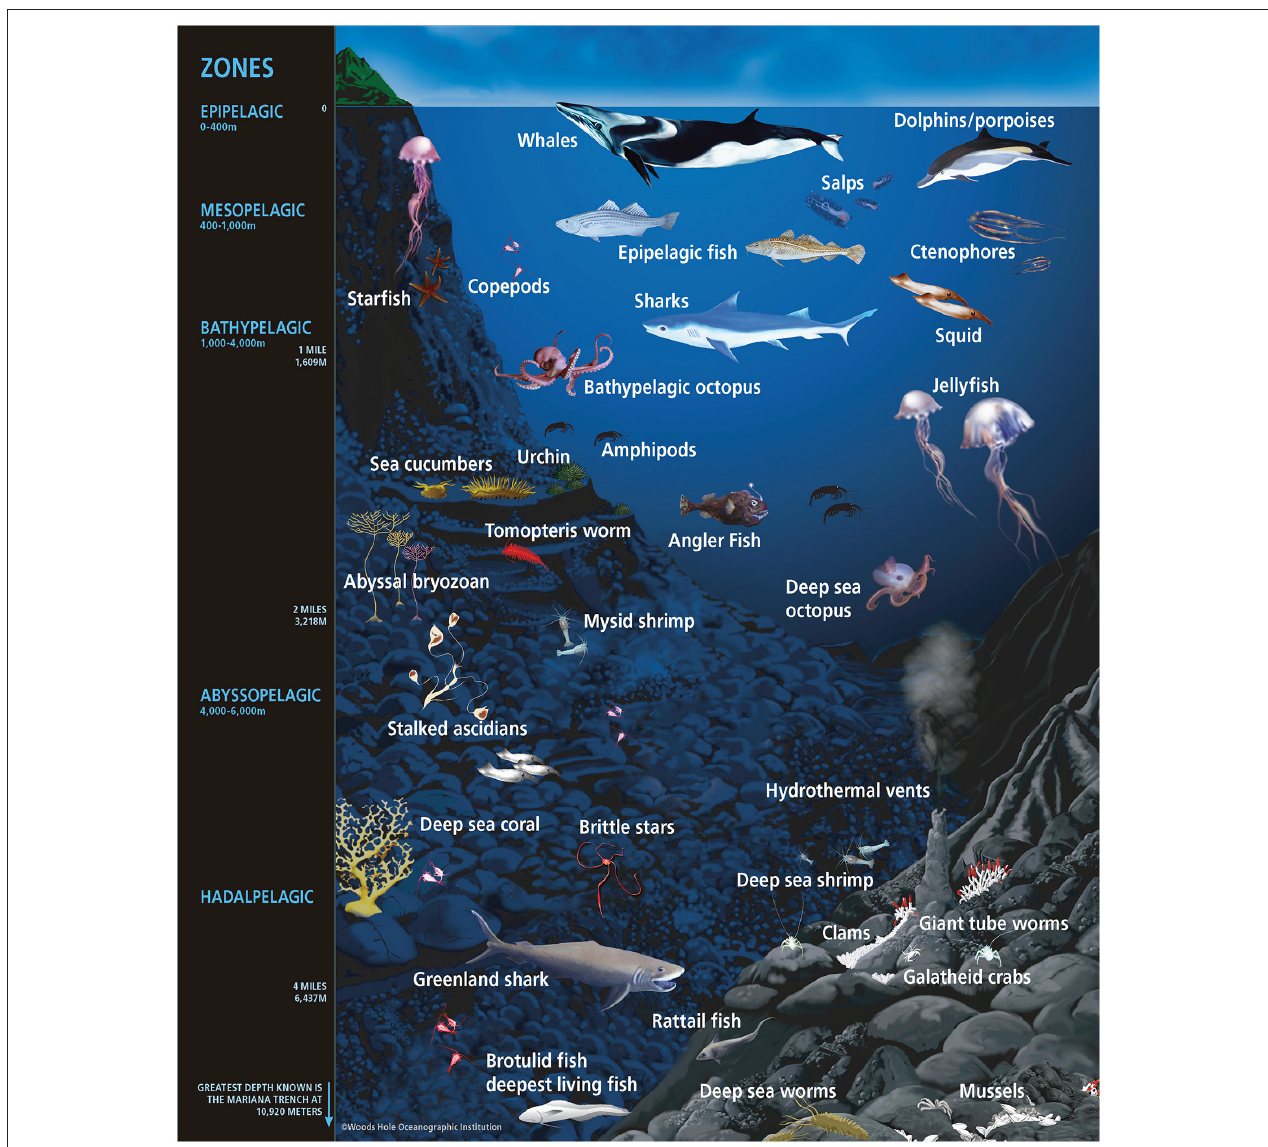
FIGURE 1 | Illustration and common names of representative ocean animal life within their approximate depth-defined ecological habitats. Microorganisms exist on the surfaces and within the tissues and organs of the diverse life inhabiting the ocean, across all ocean habitats. Animals are not drawn to